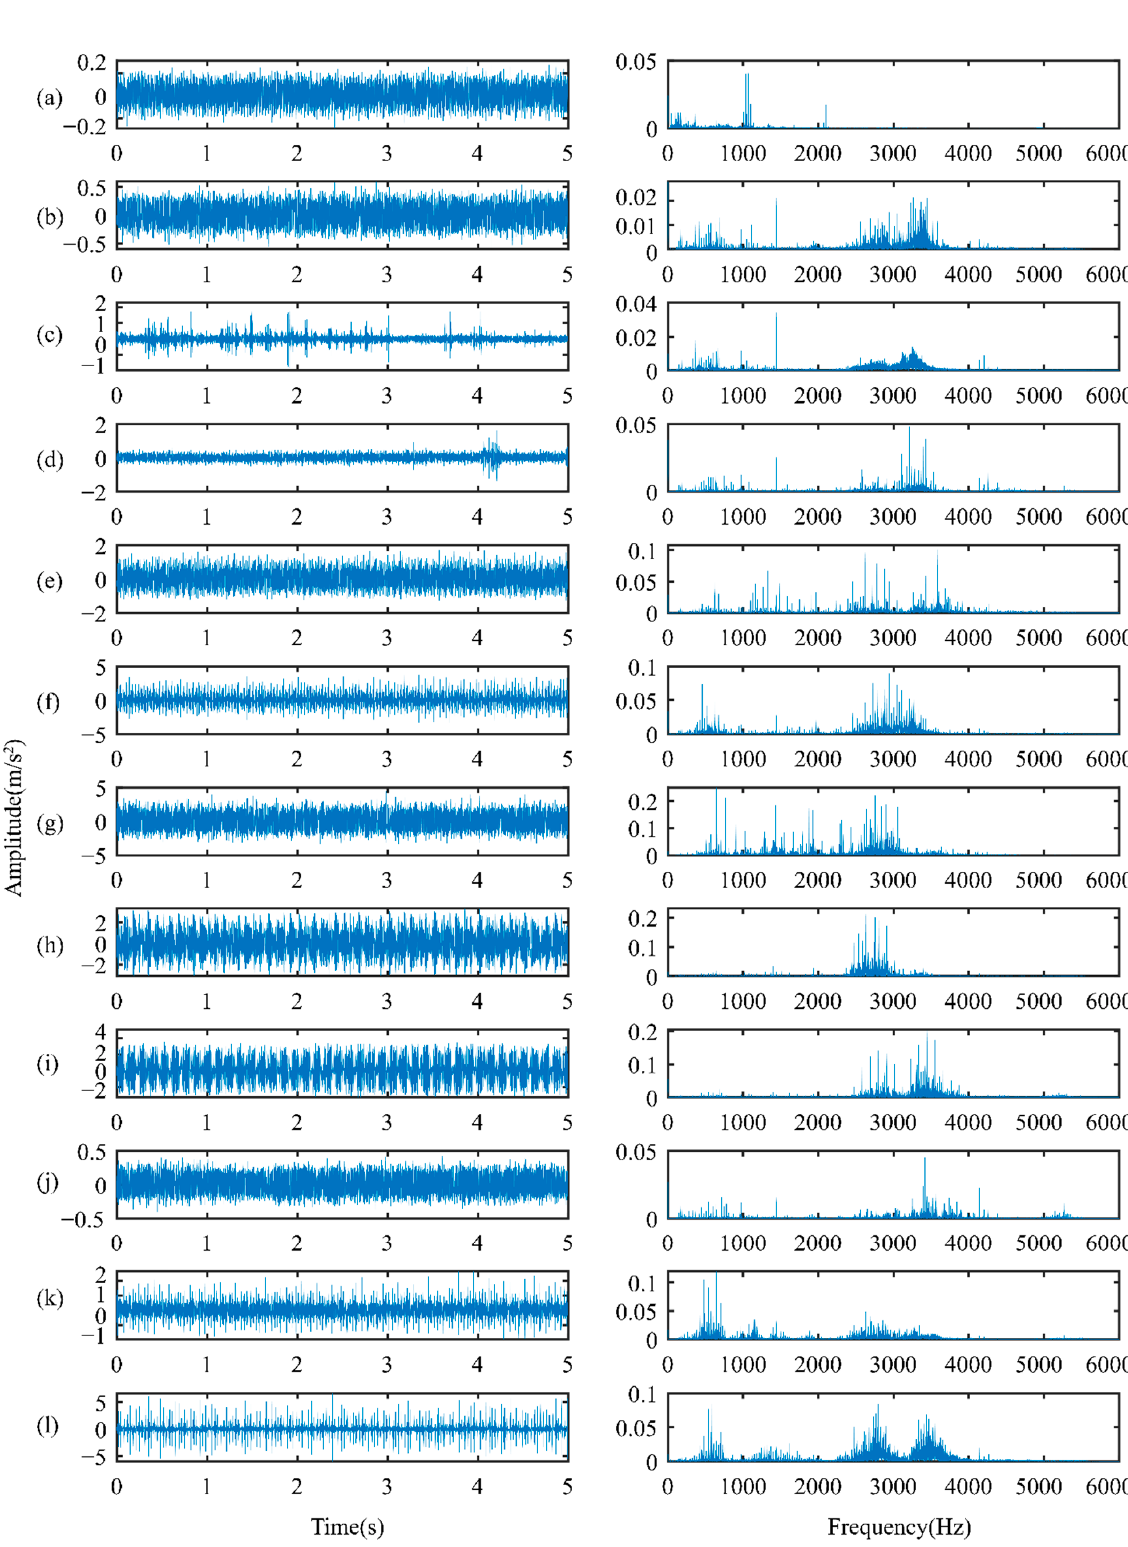
Figure 13. Waveform of raw signals and spectral distributions of the rolling bearing: ( a ) health; ( b ) rolling element failure (0.007); ( c ) rolling element failure (0.014); ( d ) rolling element failure (0.021); ( e ) inner race failure (0.007); ( f ) inner race failure (0.021); ( g ) inner race failure (0.028); ( h ) outer race failure (0.007 Center); ( i ) outer race failure (0.007 Vertical); ( j ) outer race failure (0.014 Center); ( k ) outer race failure (0.021 Center); ( l ) outer race failure (0.021 Vertical).